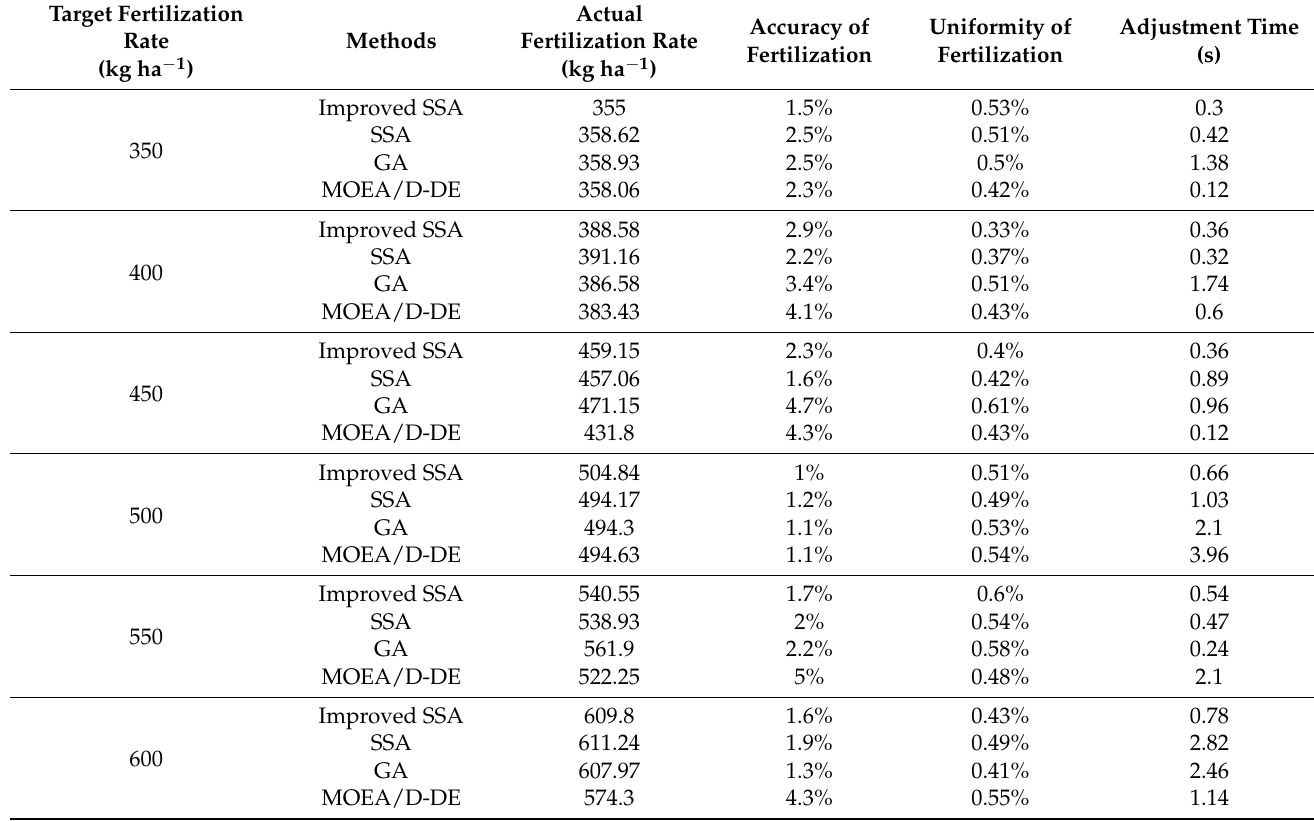
Table 9. Comparison of indoor tests of four decision-making